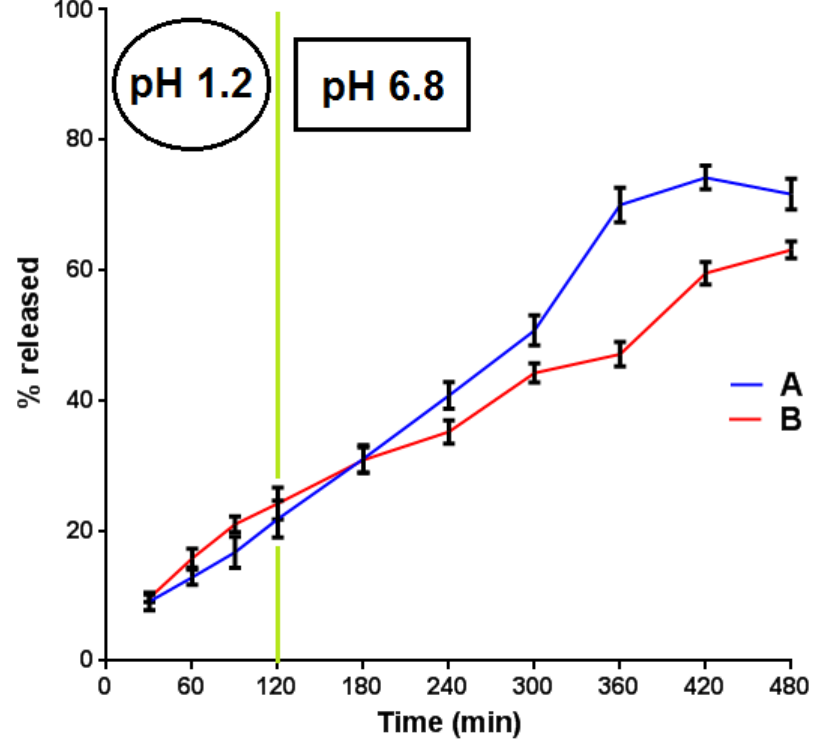
Figure 5. In vitro % release (mean values, N = 3) of BUP · HCl from formulations A and B vs. time.